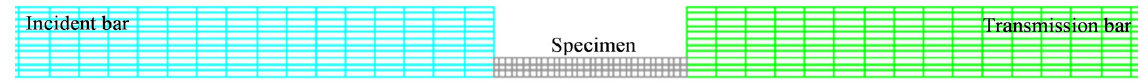
Figure 3. Structured mesh in the classical SHTB model without interruption (Model-1).